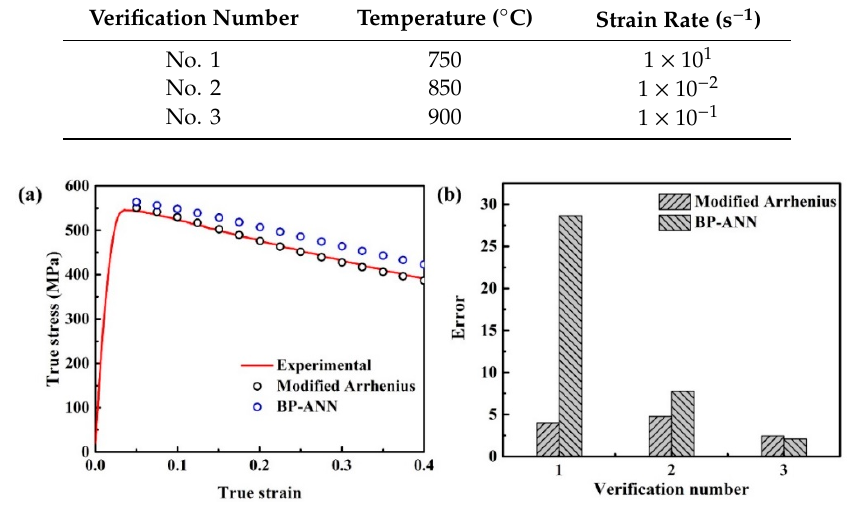
Figure 13. ( a ) Comparison between the prediction by both models and measurement and ( b ) the deviations between the measured stress and the predicted stress in cross ‐ validation.